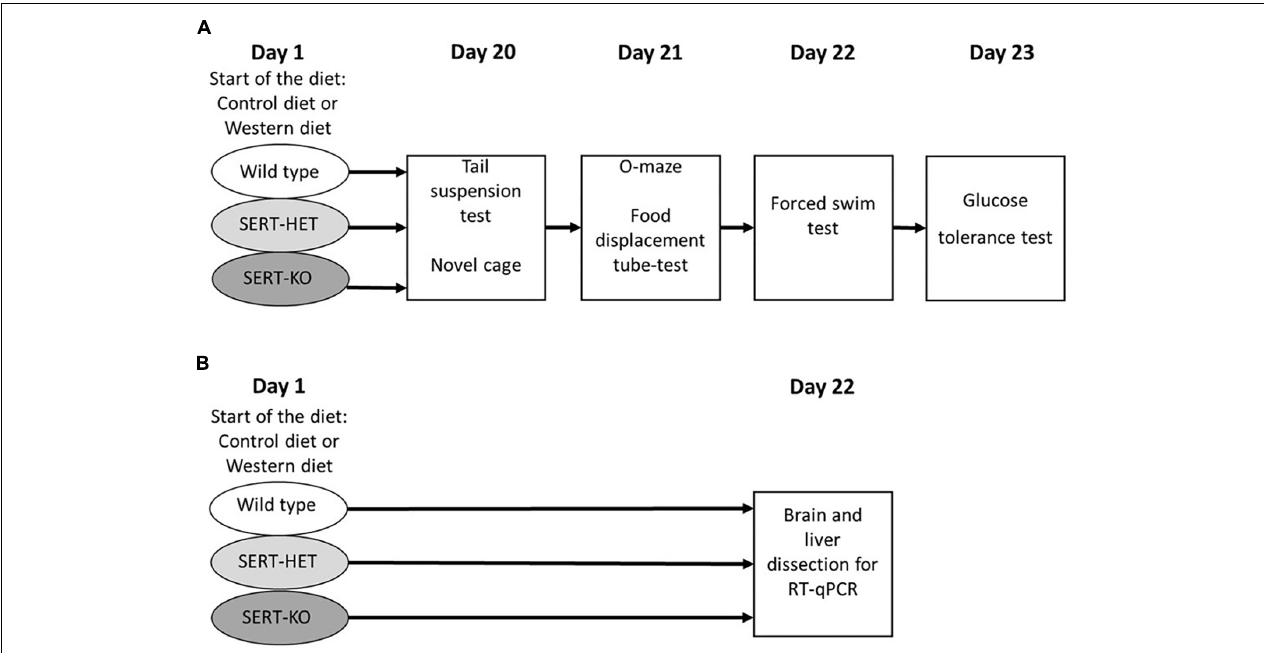
FIGURE 1 | Experimental design. (A) Study of the effects of 3-week “Western diet” (WD) feeding of wild-type (WT), heterozygous (HET), and knockout (KO) mice on behavior in tail suspension, novel cage, O-maze, food displacement, forced swim, and glucose tolerance tests. (B) Study of the effects of 3-week WD feeding of WT, HET, and KO mice on gene expression in the brain and